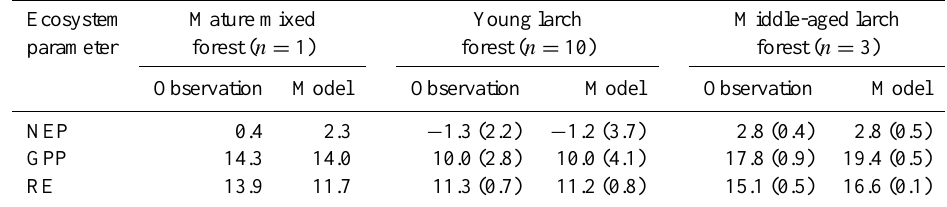
Table 2. Average annual carbon fluxes estimated for three forest types – mature mixed forest (2002 at Teshio), young larch forest (2003–2012 at Teshio), and middle-aged larch forest (2001–2003 at Tomakomai) – by field observation and the VISIT model. Units are tCha − 1 year − 1 . Values in parentheses are standard deviations.